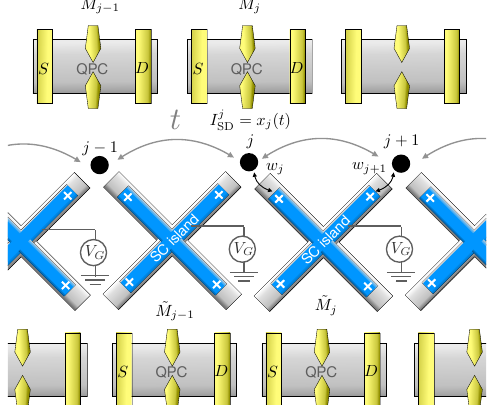
Figure 6: Detection scheme for the operator ˜ M based on a Coulomb-blockade su- j perconducting island (blue) hosting 4-Majorna zero modes (white). The fermionic chain can be realized i.e. by an array of tunnel coupled quantum dots. Two Majo- rana zero modes are tunnel coupled to adjacent chain sites, while the parity of the remaining two Majorana modes is read by a charge sensing